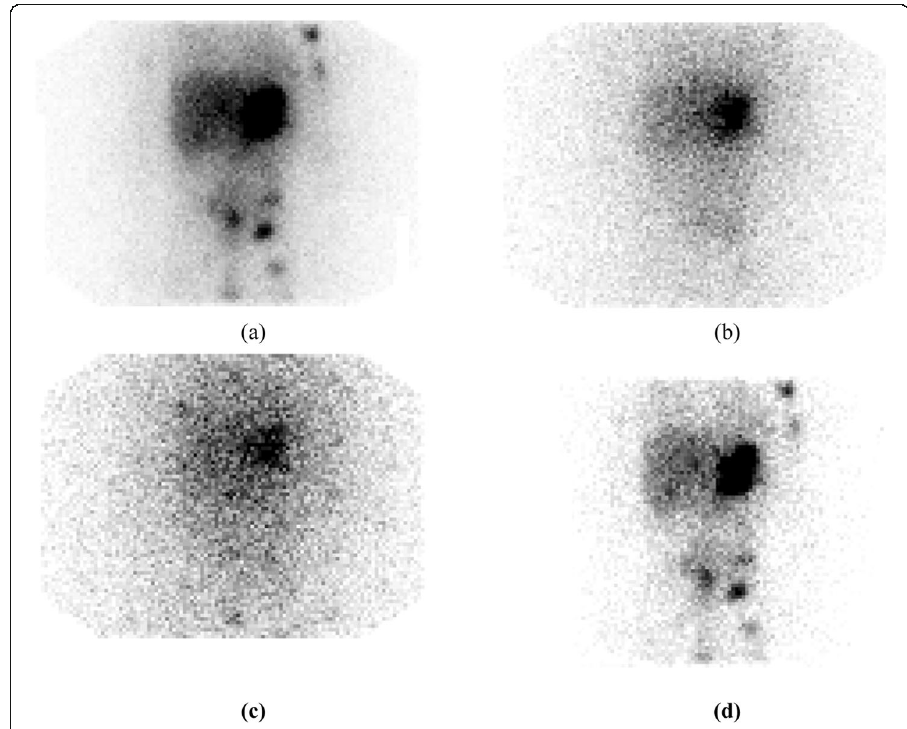
Fig. 5 Example projection data aquired in main window ( a ), low-energy scatter window ( b ), high-energy scatter widow ( c ), and after triple-energy window scatter correction ( d ). Each image is scaled to the local maxima and minima on a linear grey scale